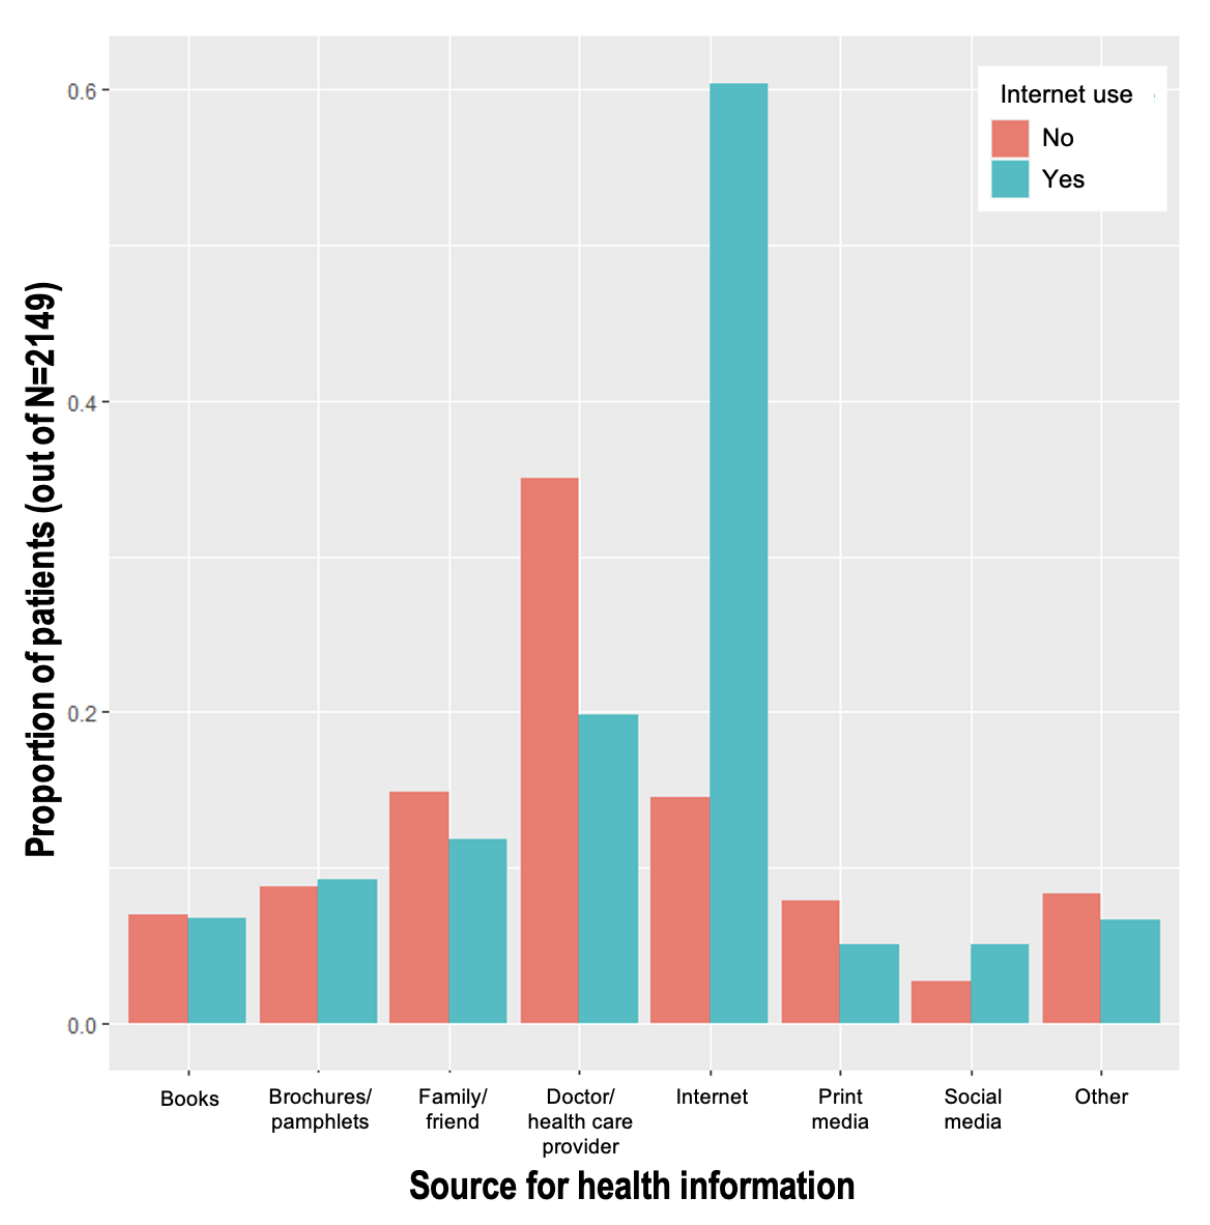
Figure 4. Source used most recently for health information by internet